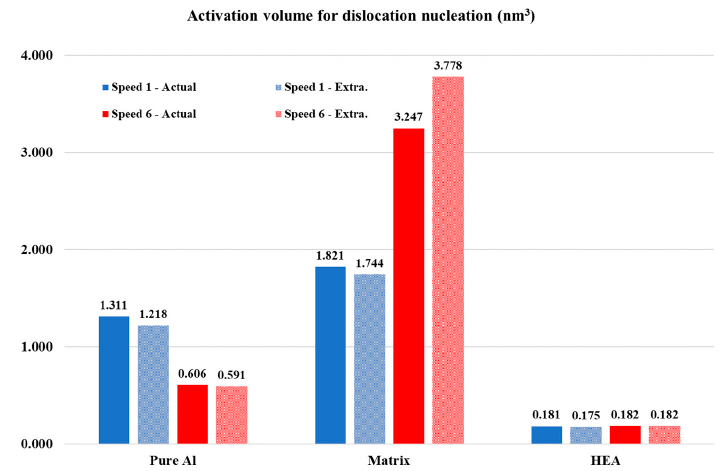
Figure 8. V cr comparison for the three areas of interest at two different creep speeds for actual and extrapolated values.